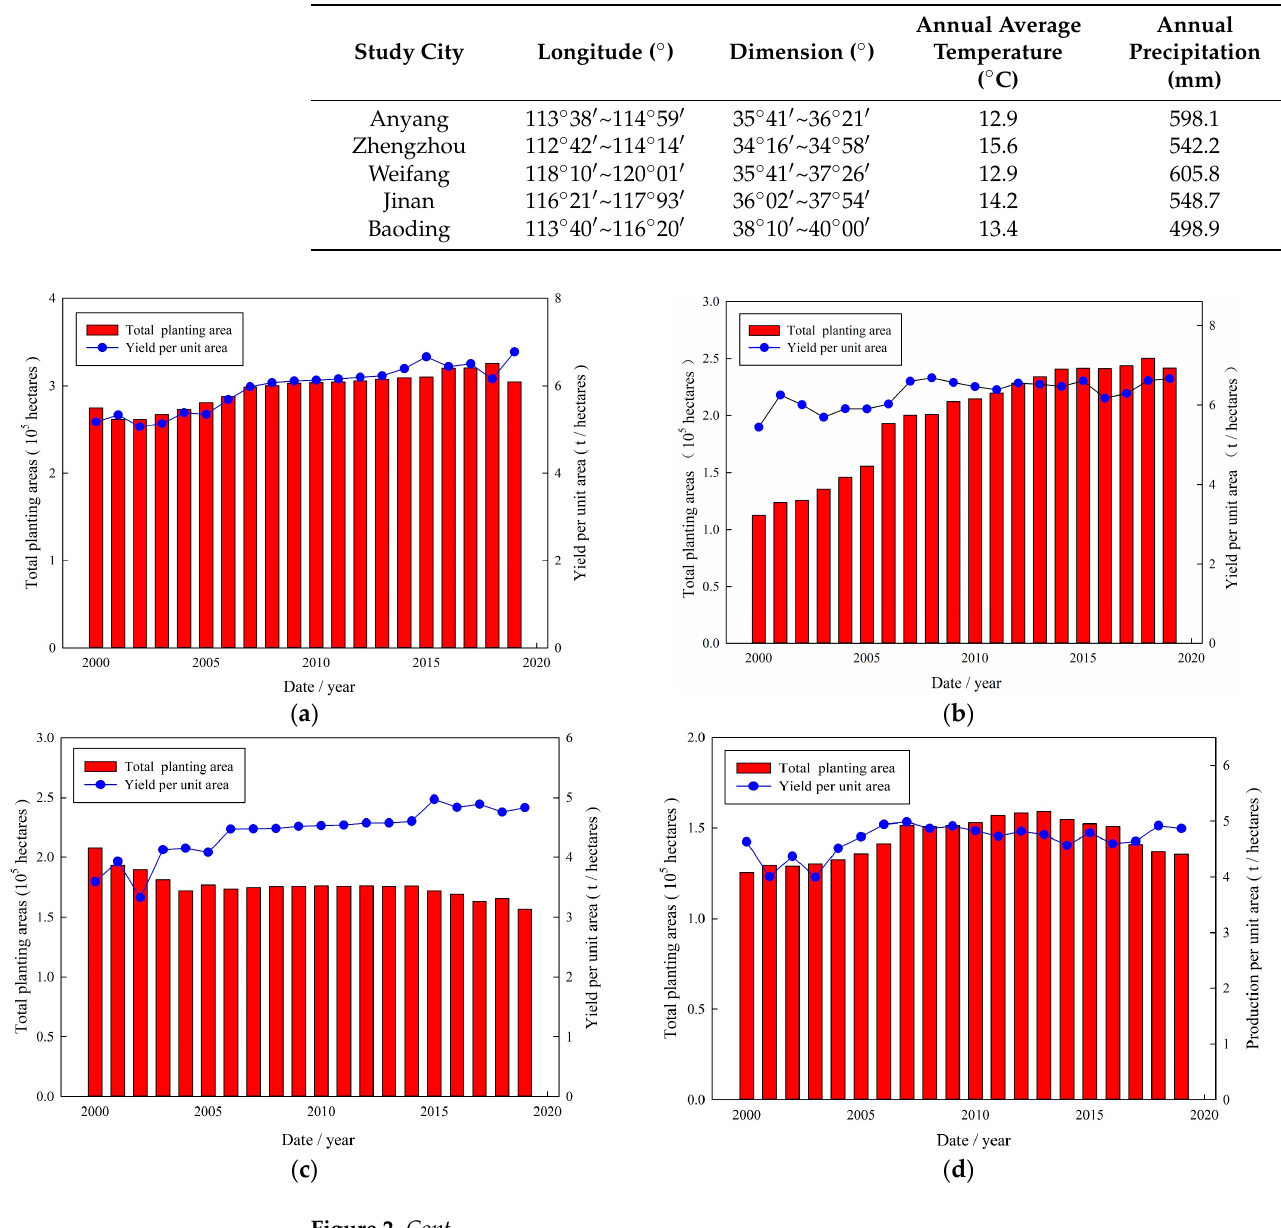
Table 1. Geographical and meteorological information of the five studied cities. Study City Longitude ( ◦ ) Dimension ( ◦ )